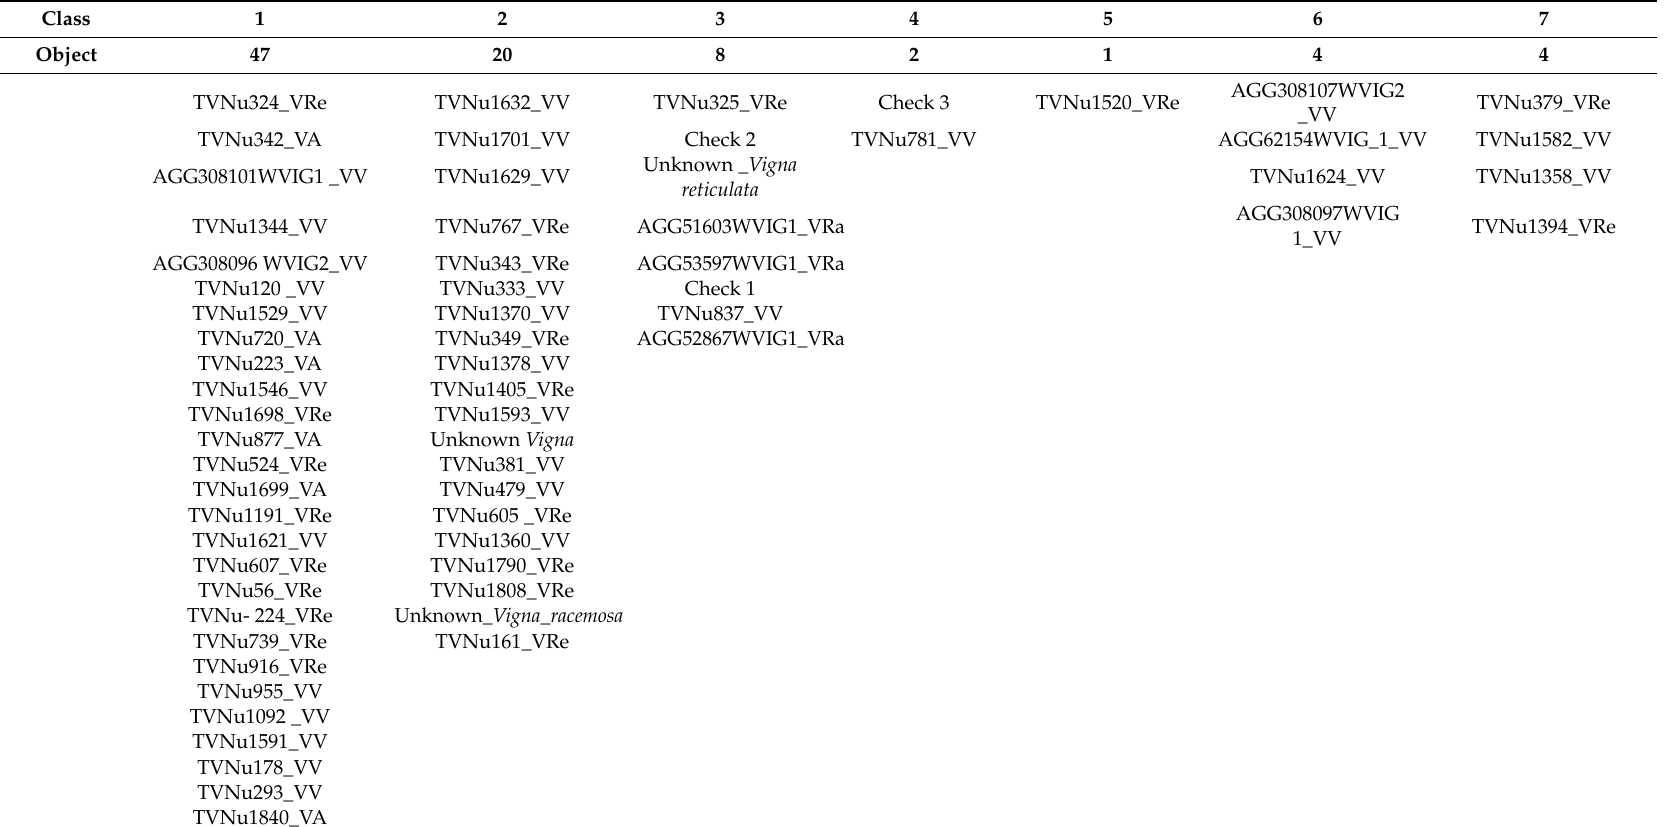
Table 7. Details of classes from the dendrogram